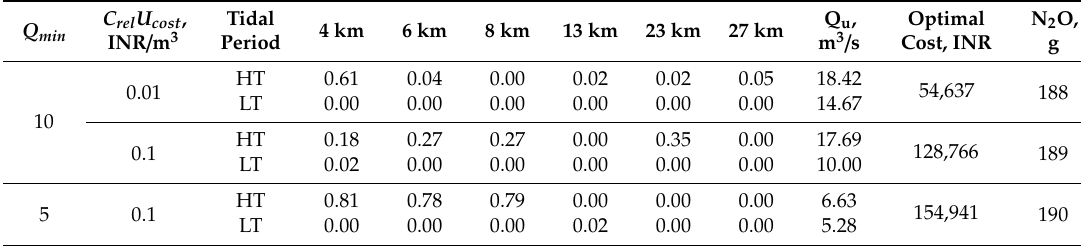
Table 2. The optimal operating schedule for cost minimisation: Case-4 and